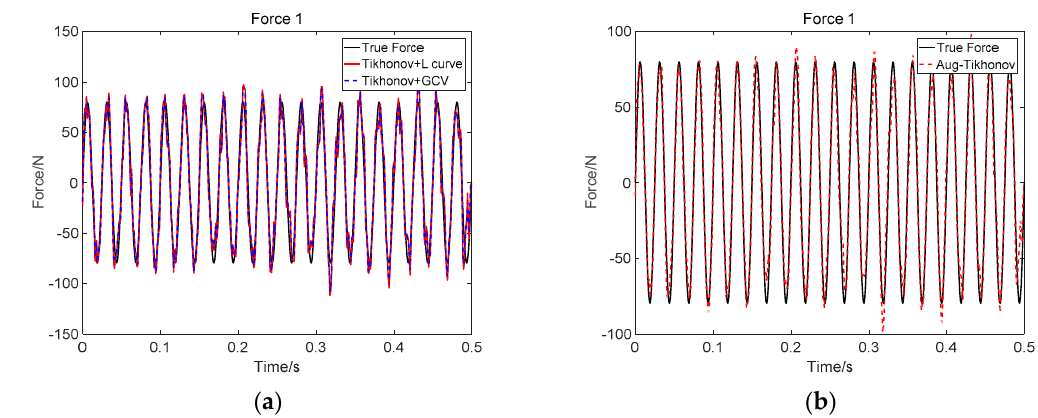
Figure 15. Identification result of two sinusoidal loads at SNR 40 dB (Force 2): ( a ) Tikhonov method; ( b ) the proposed method.